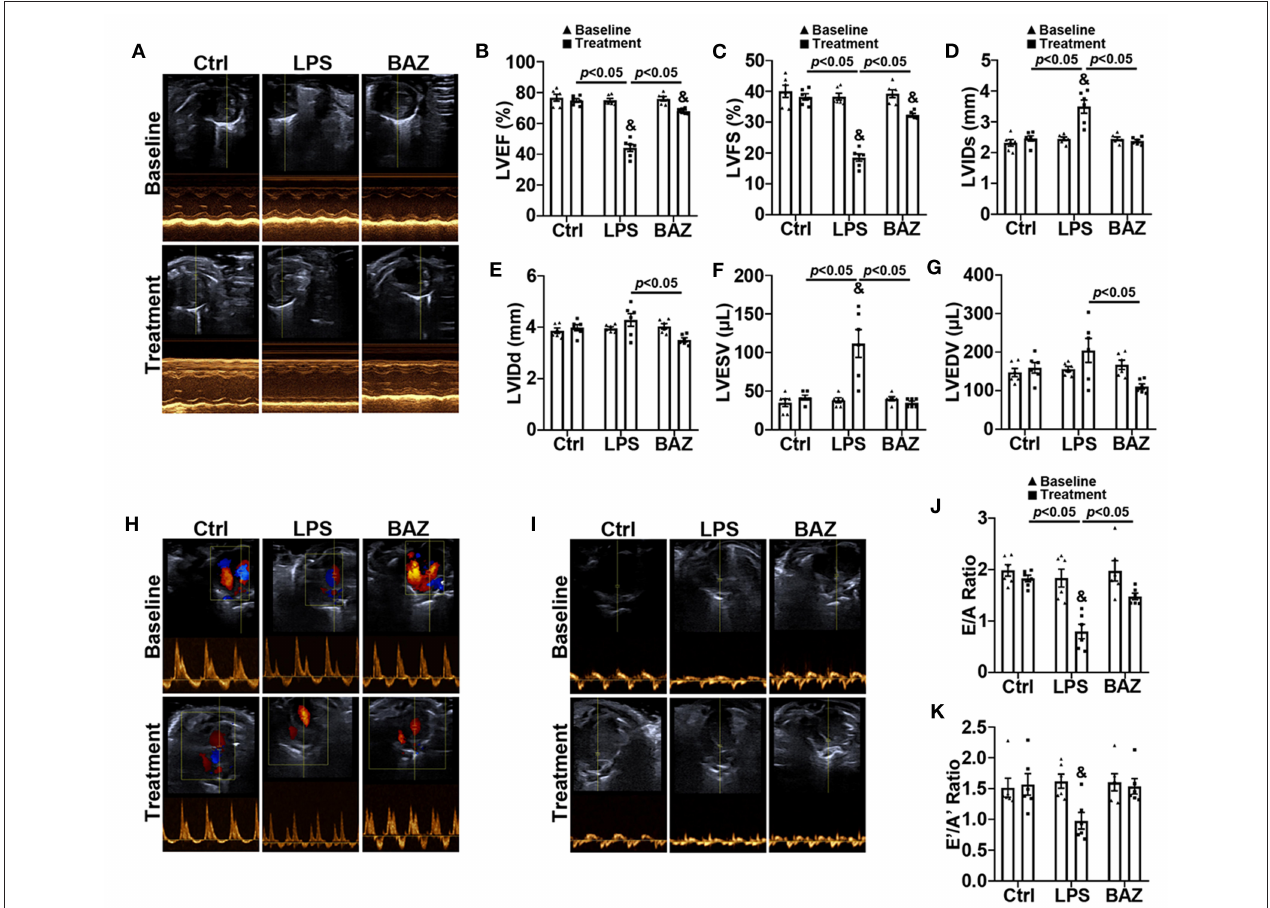
FIGURE 1 | Bazedoxifene ameliorated systolic and diastolic dysfunction in LPS-challenged mice. (A) Representative left ventricular echocardiographic M-mode images before and 12h after LPS treatment. (B–G) Mean data of left ventricular ejection fraction (LVEF) (B) , left ventricular fractional shortening (LVFS) (C) , left ventricular internal dimensions at end systole (LVIDs) (D) and diastole (LVIDd) (E) , left ventricular volumes at end systole (LVESV) (F) and diastole (LVEDV) (G) . (H,I) Representative echocardiographic images from pulse-wave Doppler imaging (H) and tissue Doppler imaging (I) at the apical four-chamber view before and 12h after LPS treatment. (J) Ratio of pulse-wave Doppler E wave to A wave amplitude. (K) Ratio of tissue Doppler E’ wave to A’ wave amplitude. n = 6 per group. Data represent means ± S.E.M. & p < 0.05 vs. baseline; Statistical analyses were performed using two-way ANOVA followed by Bonferroni’s post-hoc test. BAZ,